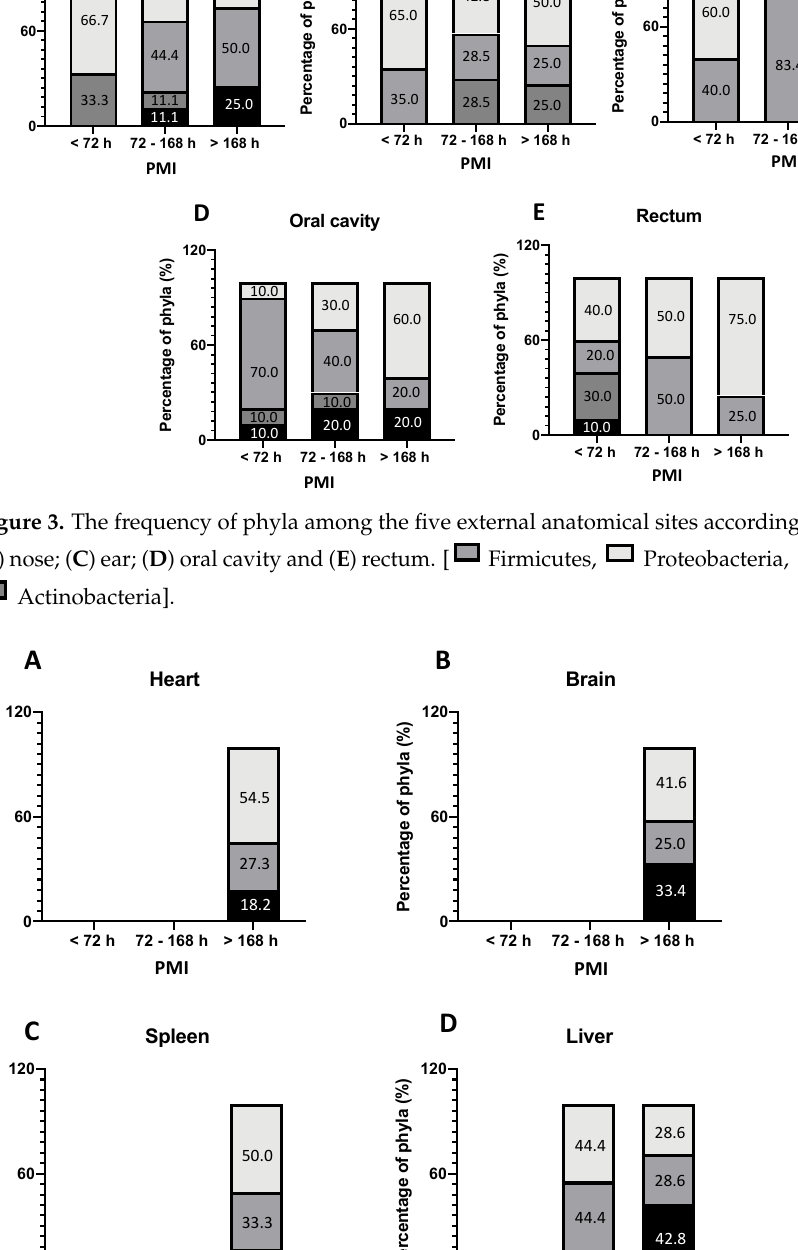
Figure 2. The distribution of genera among the four internal anatomical sites: A) heart; B) brain; C) spleen and D) liver.